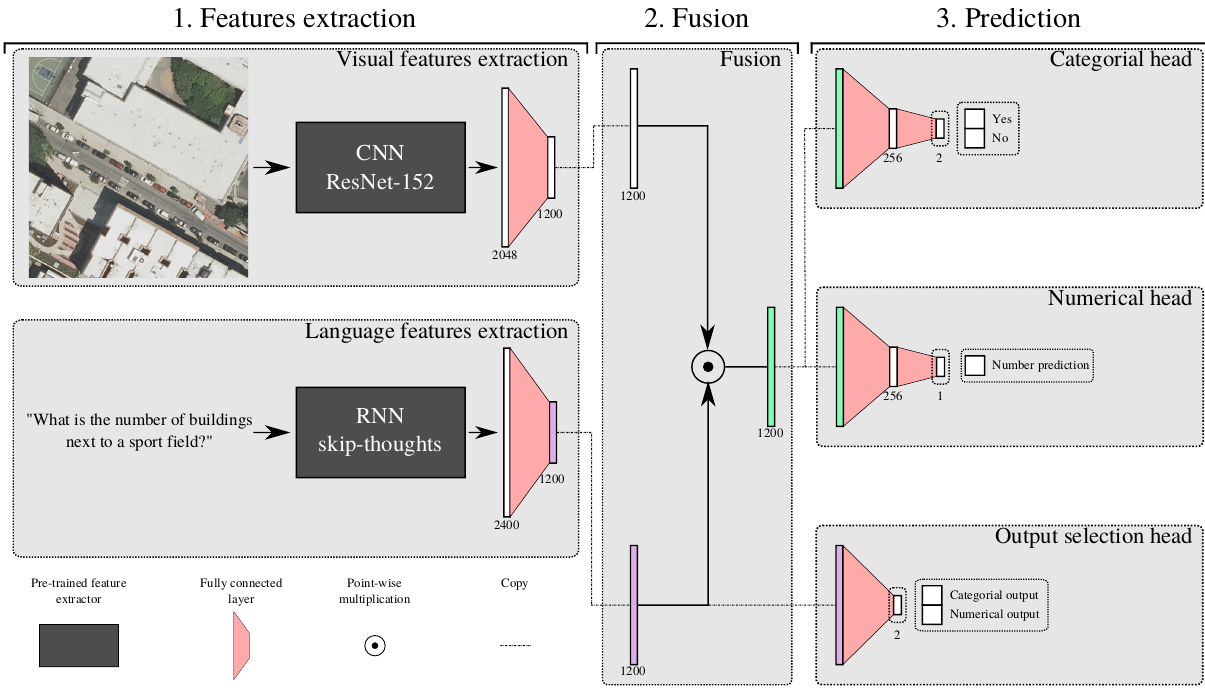
Figure 3. Architecture of the proposed